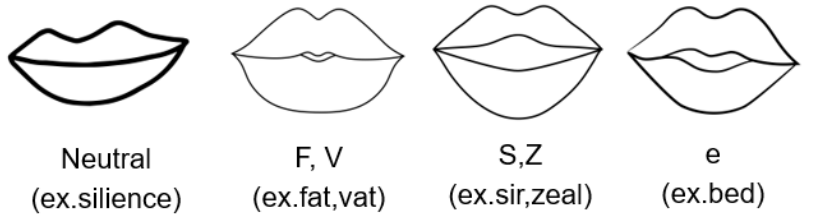
Figure 4. Examples of the virtual human’s lip movements (e.g., neutral, F/V, S/Z, e): phonemes represent the visual movements of the lips and facial expressions.